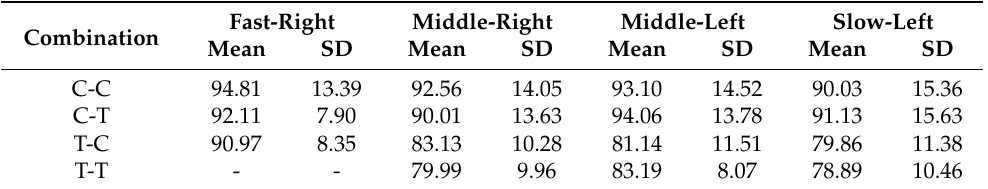
Table A1. The mean and standard deviation of m velocity.